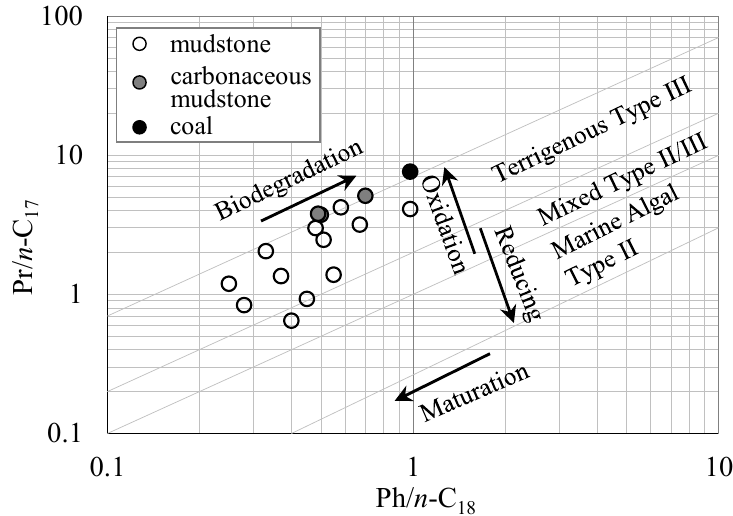
Figure 6. Variation of TOC ( a ), TAR ( b ), P aq ( c ), P wax (c), Pr/Ph ( d ), diterpanes/ n- C 19–20 (Di/ n- C 19–20 ; ( e ), oleanane/C 30 hopane (O/C 30 H; ( f) ), diterpanes/(diterpanes + non-hopanoid triterpanes) [Di/(Di + Tri); ( g )], C 29 steranes/C 30 hopane (C 29 St/C 30 H; ( h )), C 27 /C 29 ααα 20R sterane ( i ), and C 29 diasteranes/C 29 steranes (diaC 29 /C 29 St; ( j )) with depth for the studied source rocks.